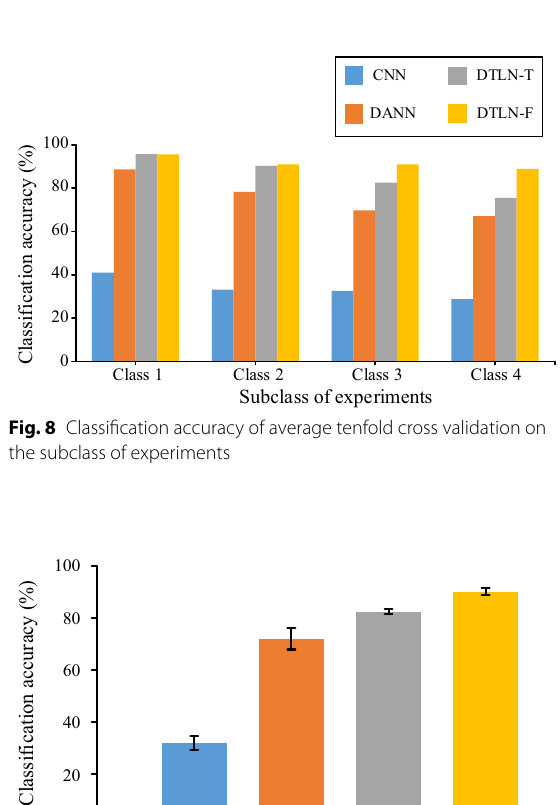
samples. The accuracies and standard deviations on the 16 transfer fault diagnosis experiments are shown in Table 4. Classification accuracies of average tenfold cross